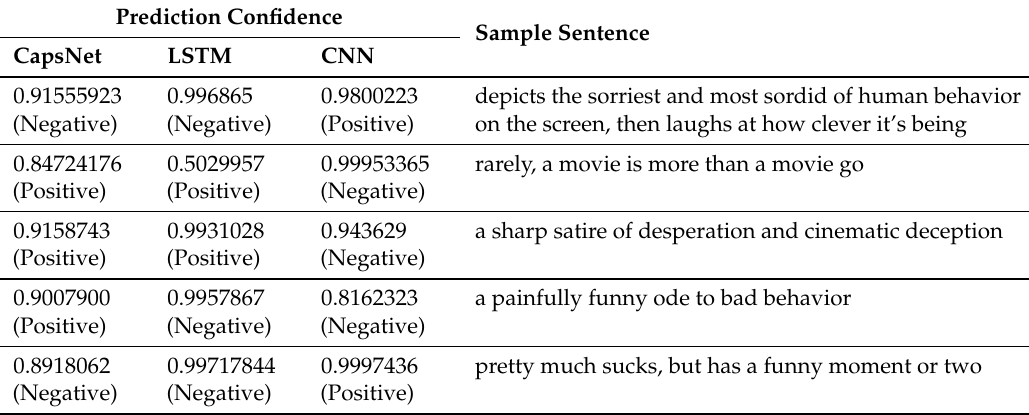
Table 6. Sample sentences correctly predicted by CapsNet and Incorrectly predicted by